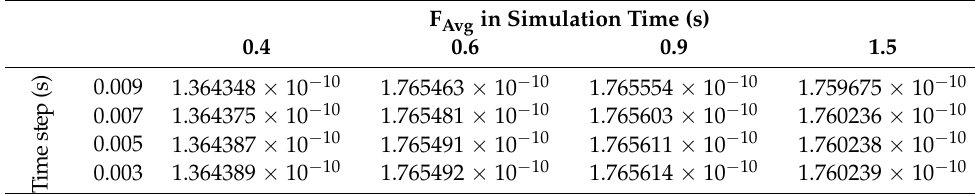
Table 5. Time-step independence study of F Avg